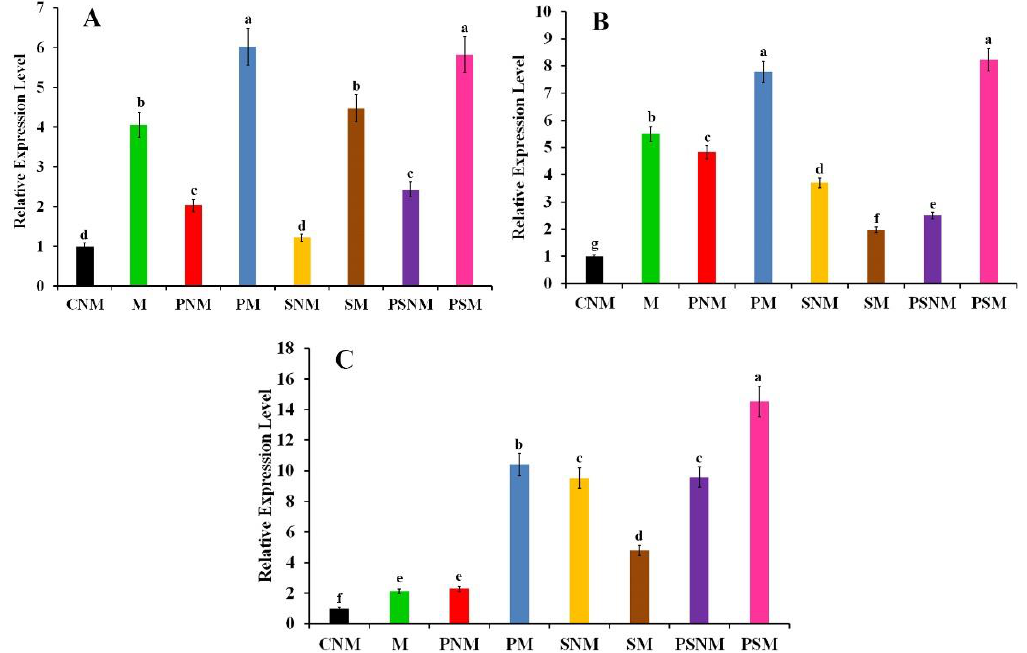
Figure 2. Histograms showing the gene expression profiles of the responsive factor JERF3 ( A ) and the defense-related genes GLU ( B ) and PR1 ( C ) in pea roots infected with Fusarium wilt in response to application of S. viridosporus HH1 and/or colonization with R. irregularis two weeks post planting. Where CNM: uninfected, untreated, and non-mycorrhizal, M: uninfected, untreated, and mycorrhizal, PNM: infected, untreated, and non-mycorrhizal, PM: infected, untreated, and mycorrhizal, SNM: uninfected, treated with S. viridosporus HH1, and non-mycorrhizal, SM: uninfected, treated with S. viridosporus HH1, and mycorrhizal, PSNM: infected, treated with S. viridosporus HH1, and non-mycorrhizal, PSM: infected, treated with S. viridosporus HH1, and mycorrhizal. For each gene, columns superscripted with the same letter are not significantly different according to Tukey’s HSD test at p ≤ 0.05. Three biological and three technical replicates were applied for each treatment. Error bars represent standard errors.